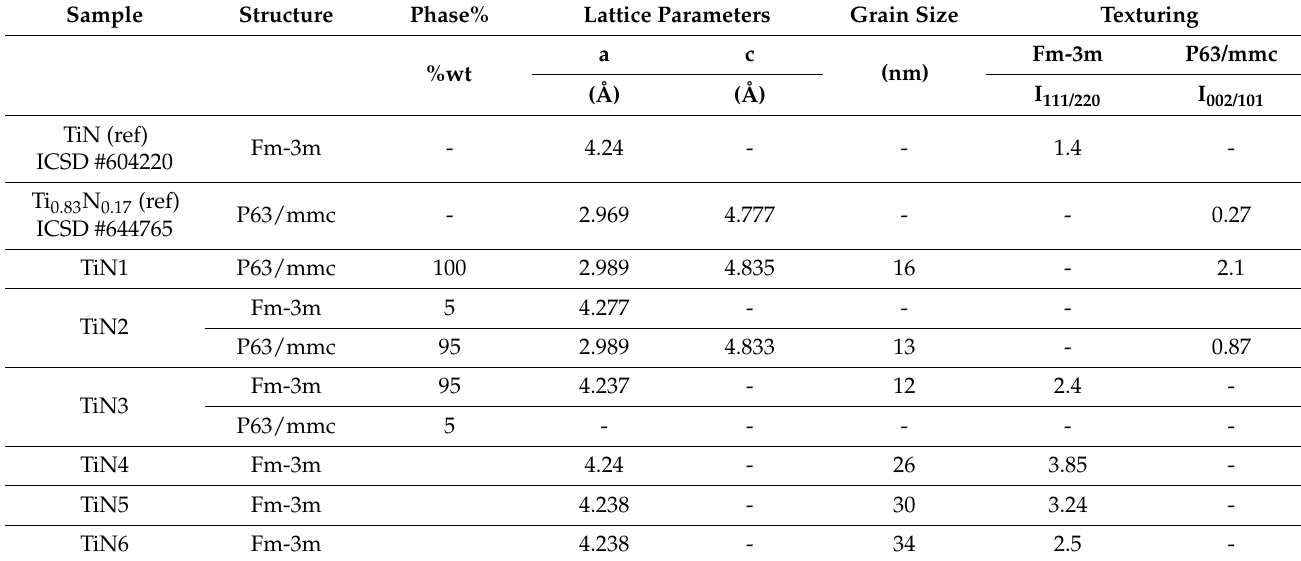
Figure 4. XRD spectra deposited with N 2 > 1.2 sccm. Table 3. Microstructure, lattice parameters, crystallite size and texture of TiN 1-x